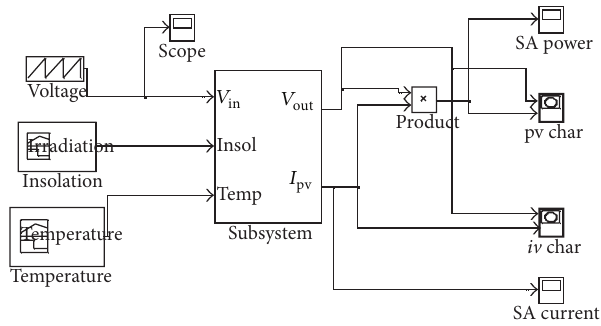
Figure 3: SA block model applied in